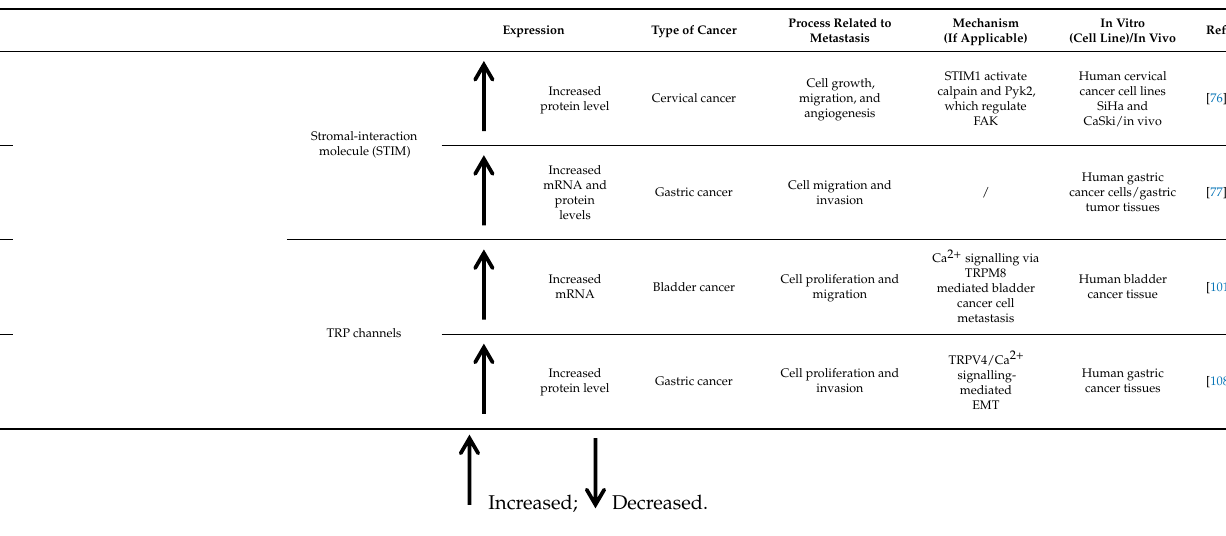
Table 1. Some experimental evidence supporting Ca +2 signalling-mediated cancer metastasis.